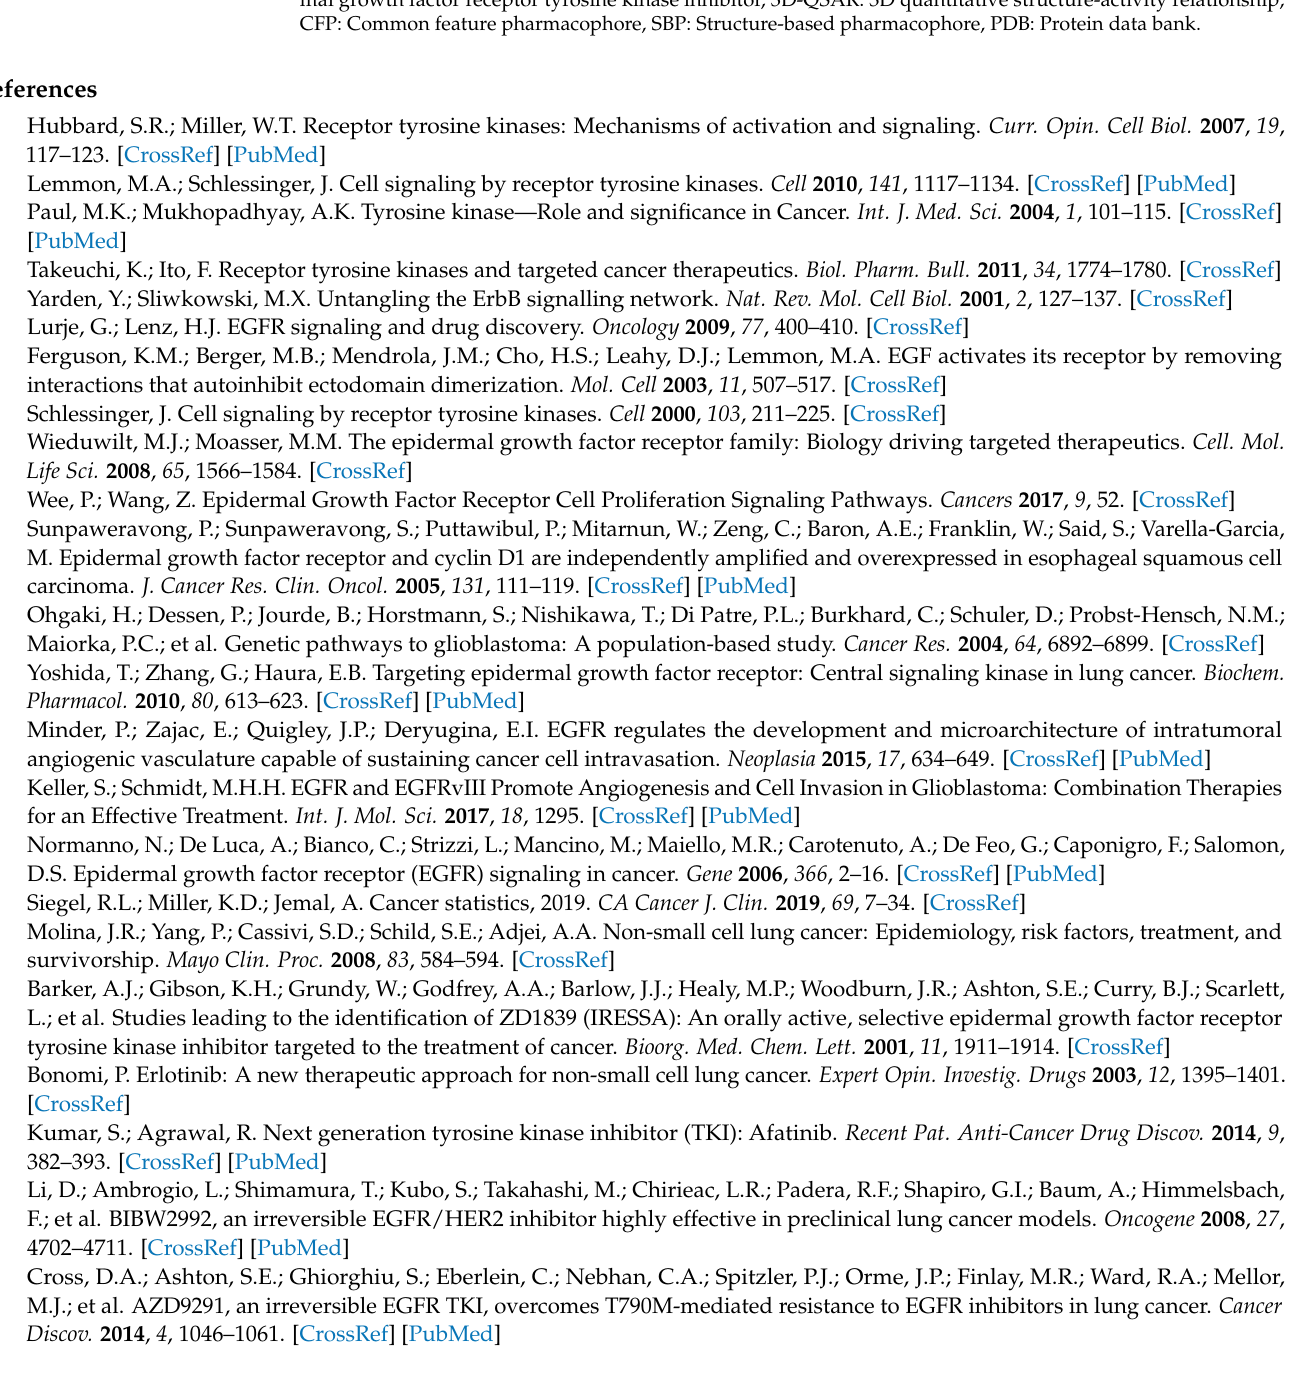
Note: Bold indicates values used as criteria during the multiple-stage pharmacophore-based virtual screening coupled with molecular docking. Abbreviations- EGFR : Epidermal growth factor receptor, EGFR-TKI: Epider- mal growth factor receptor tyrosine kinase inhibitor, 3D-QSAR: 3D quantitative structure-activity relationship, CFP: Common feature pharmacophore, SBP: Structure-based pharmacophore, PDB: Protein data